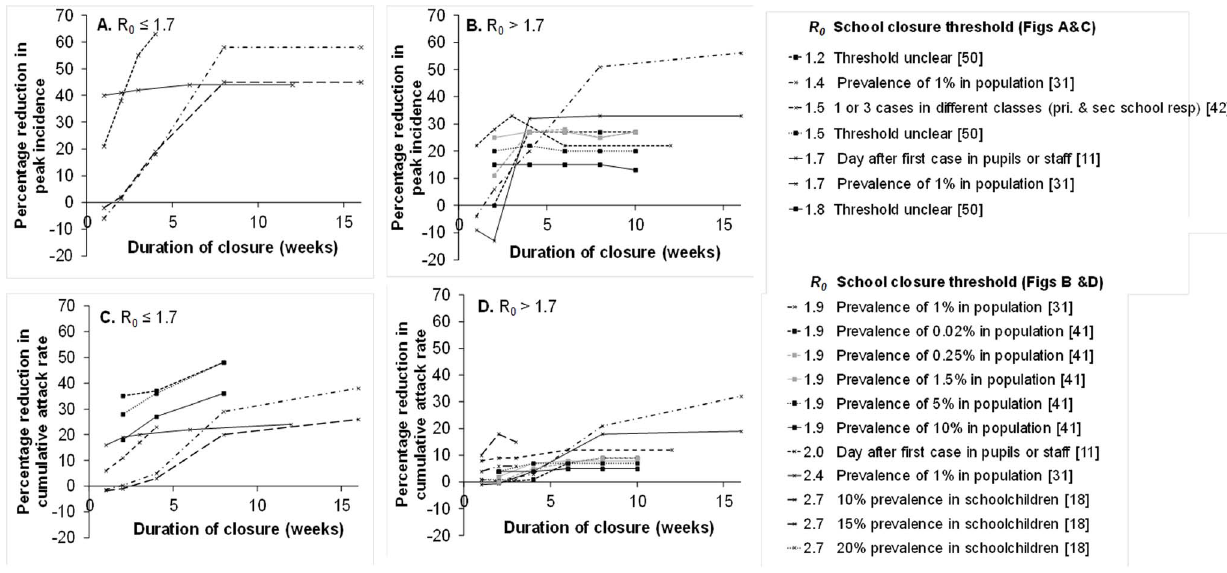
Figure 4. Influence of the duration of school closure on the predicted effects on pandemic influenza. Reductions in peak incidence (A and B) and cumulative attack rates (C and D) for different values of R 0 and assumed thresholds for school closure. Lines join predictions from the same model using the same sets of assumptions.